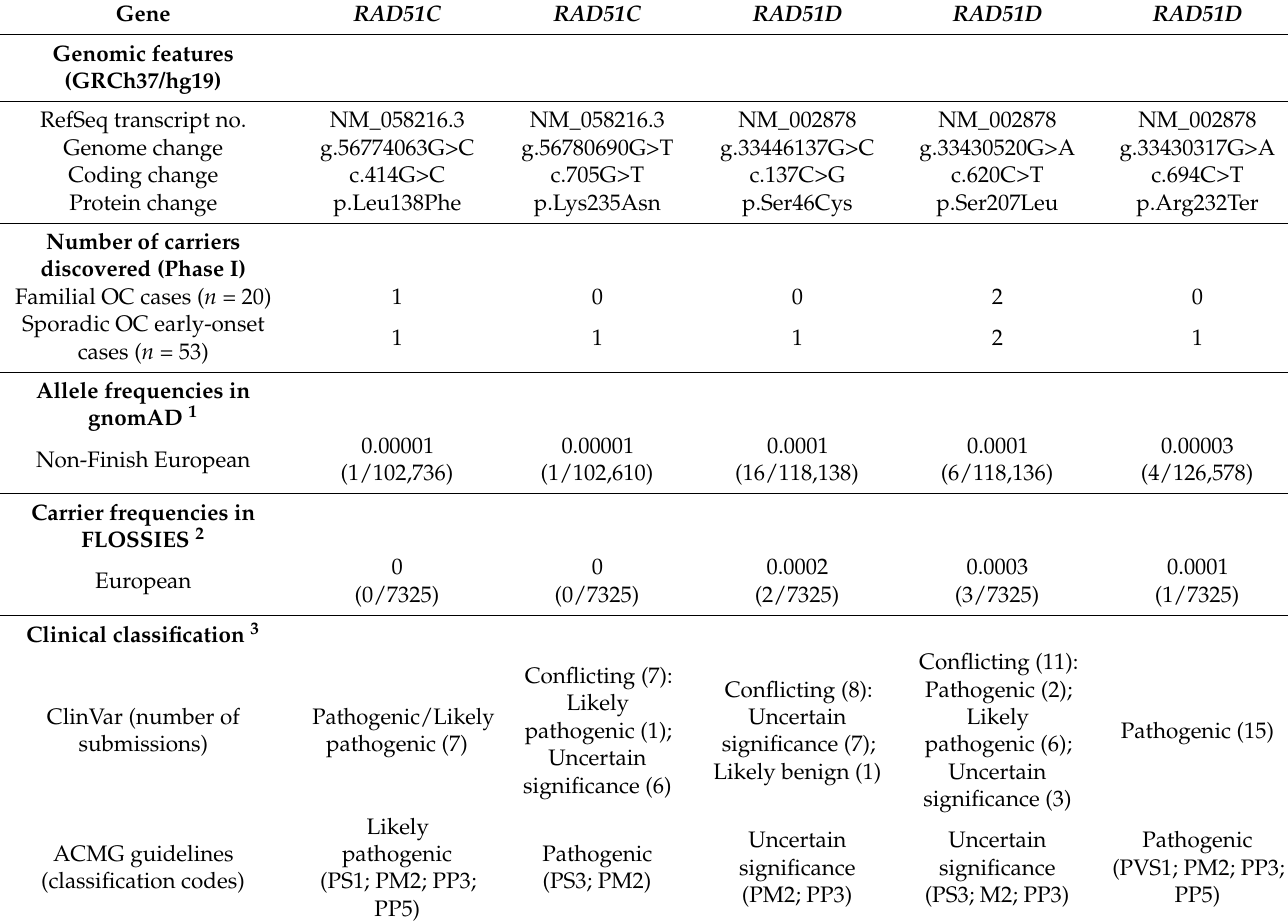
Table 1. Characteristics of candidate variants identified in RAD51C and RAD51D